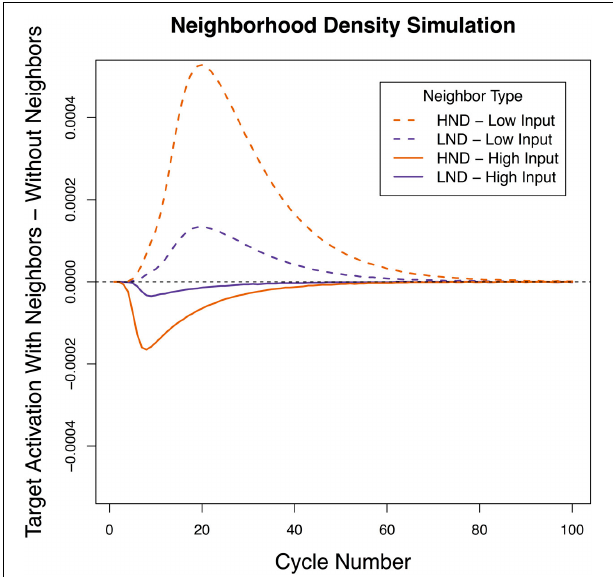
FIGURE 6 | Net contribution of a handshape neighbor and a location neighbor when the number of neighbors was manipulated. Both high and low levels of external input are presented. Both handshape and location neighbors had a net facilitatory effect on the target when the external input was low, and both handshape and location neighbors had a net inhibitory effect on the target when the external input was